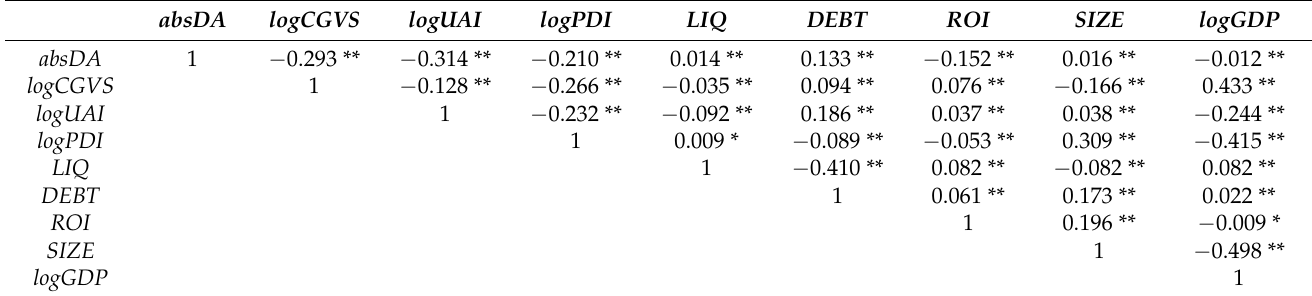
Table 4. Pearson correlations (variables in Equation (1)).